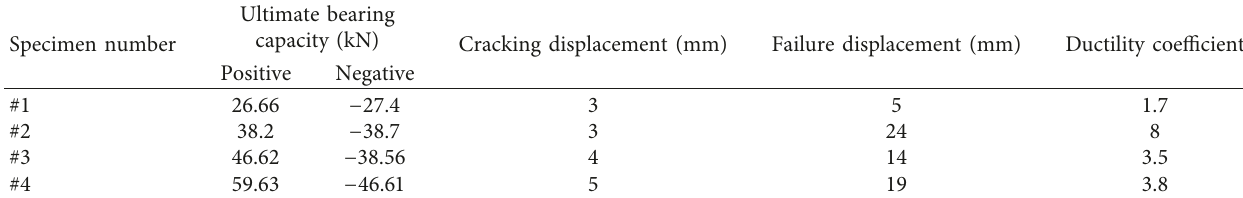
Figure 6: Comparison of stiffness degradation of specimens. Table 3: Ultimate bearing capacity and ductility coefficients of